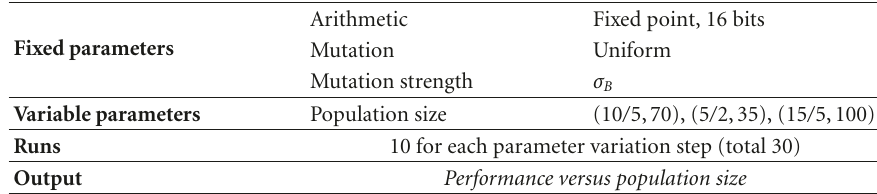
Table 8: Test no. 4. E ff ect of the population size.